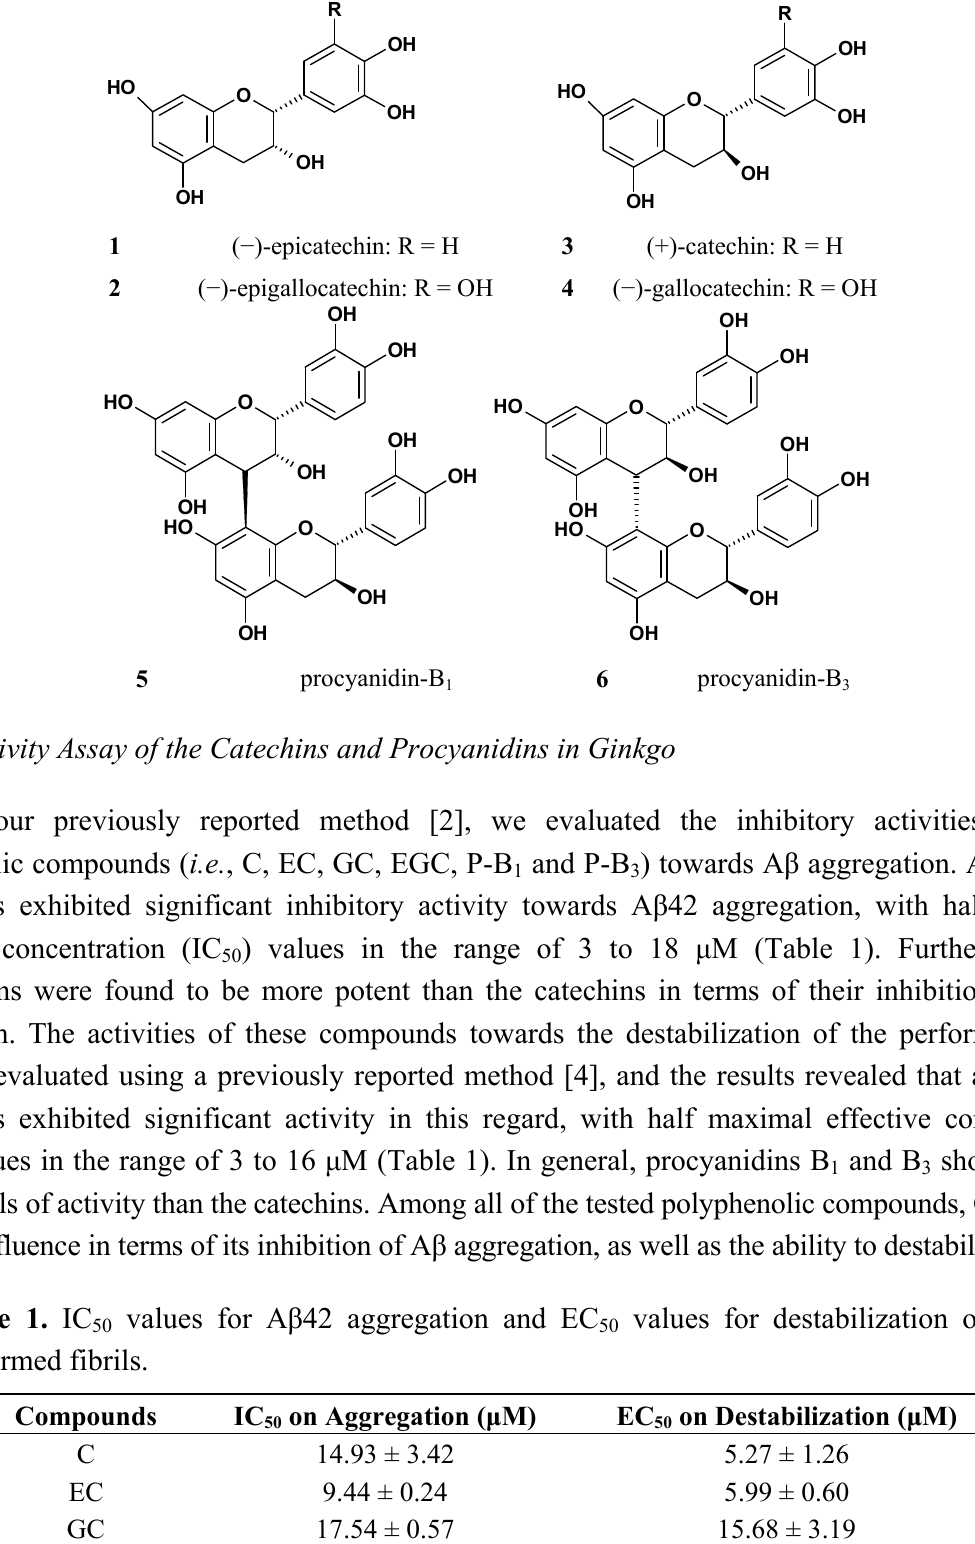
values for destabilization of the 50